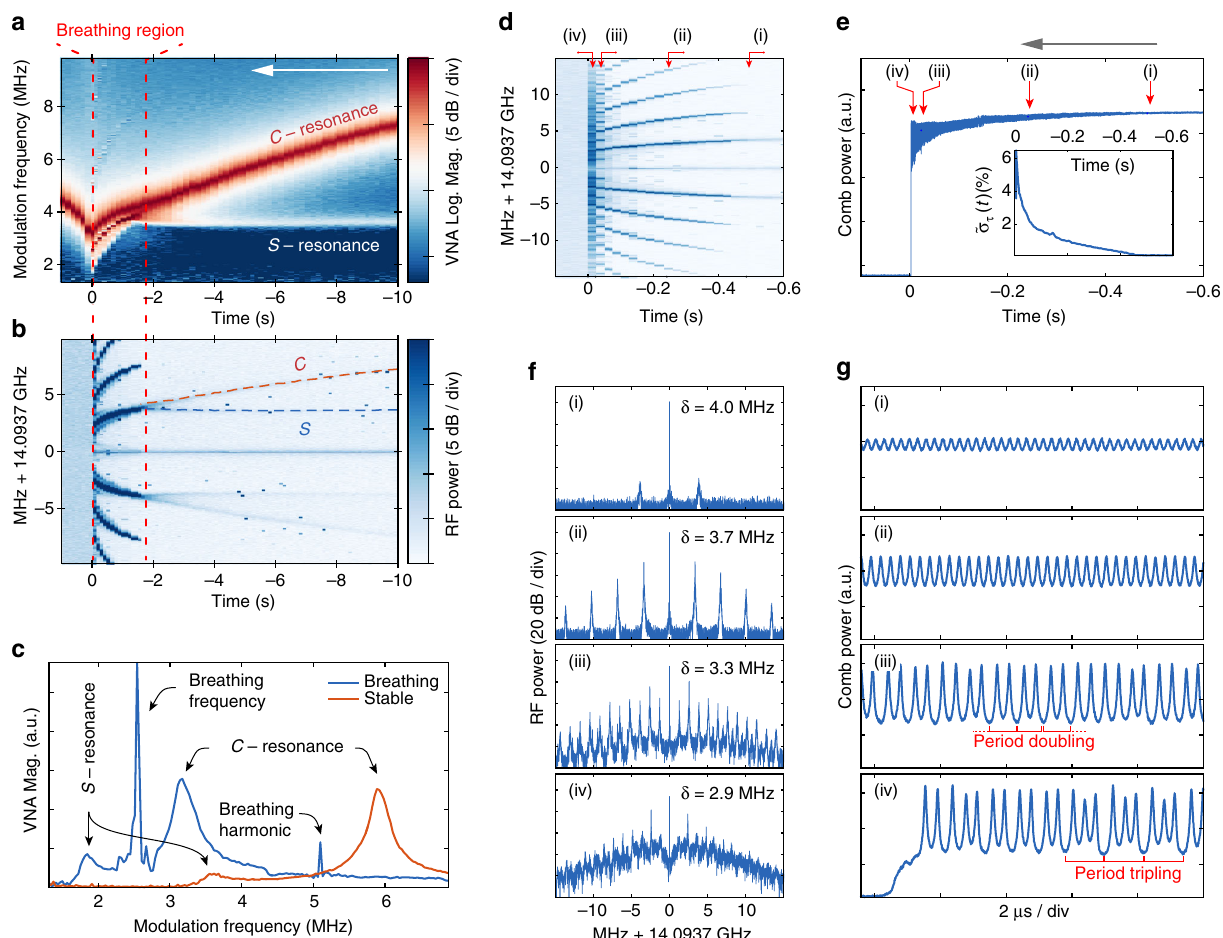
Fig. 3 Evolution of the breathing dynamics of a single soliton in backward tuning in the MgF 2 resonator. a Map of concatenated vector network analyser (VNA) traces showing the evolution of the modulation response (log scale) from stationary soliton on the right of the time axis to breathing and decay on the left (the time origin t = 0 s, is set at the soliton decay). As the laser is tuned towards shorter wavelength, the effective detuning ( C -resonance) is reduced. The breathing starts typically when the separation of the C - and S -resonances is on the order of the resonator linewidth. b Corresponding spectrum of the comb repetition rate beatnote. The modulation response measured on the VNA is also visible in the noise of the RF beatnote spectrum (the dotted lines correspond to the C -frequencies and S -frequencies determined on the VNA). The breathing is indicated by the formation of sidebands around the repetition rate beatnote. As the detuning is reduced, the breathing frequency decreases until the soliton is lost. c Recorded modulation response in the state of a breathing and stationary soliton (linear scale). d Zoom-in spectrogram of the repetition rate beat within the breathing region and e corresponding generated comb light evolution. The inset shows the evolution of the relative standard deviation. f Repetition rate beatnote spectra in the various breathing stages (i) – (iv) highlighted in d , e (resolution bandwidth 2 kHz). g Recording of generated light power oscillations at the points (i) –